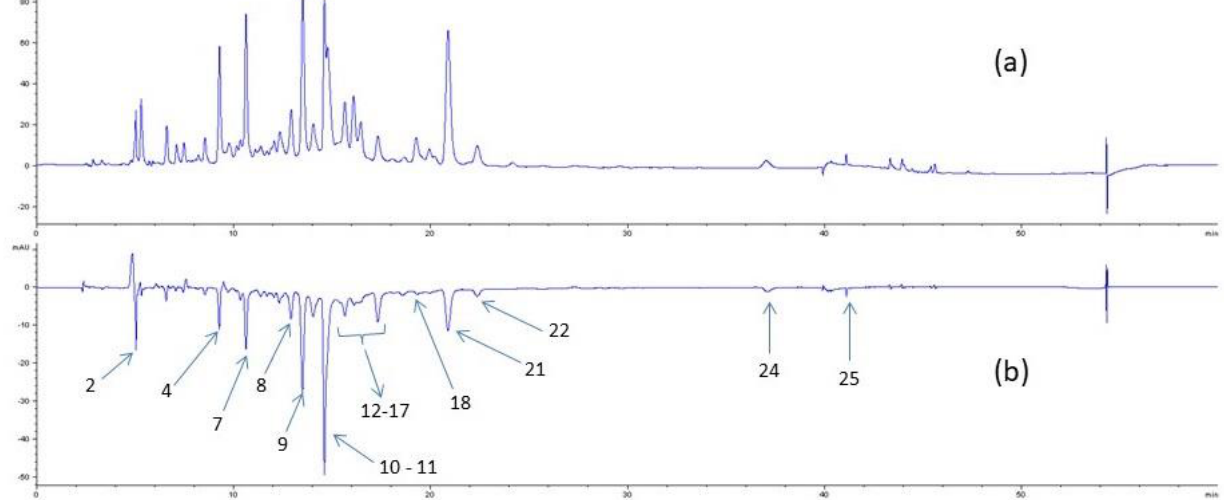
Figure 4. HPLC-UV 254 nm profiles of F. ulmaria aerial parts methanolic extract: ( a ) crude extract; ( b ) difference of the chromatogram of the crude extract without and with the enzyme (negative peaks indicate interaction).